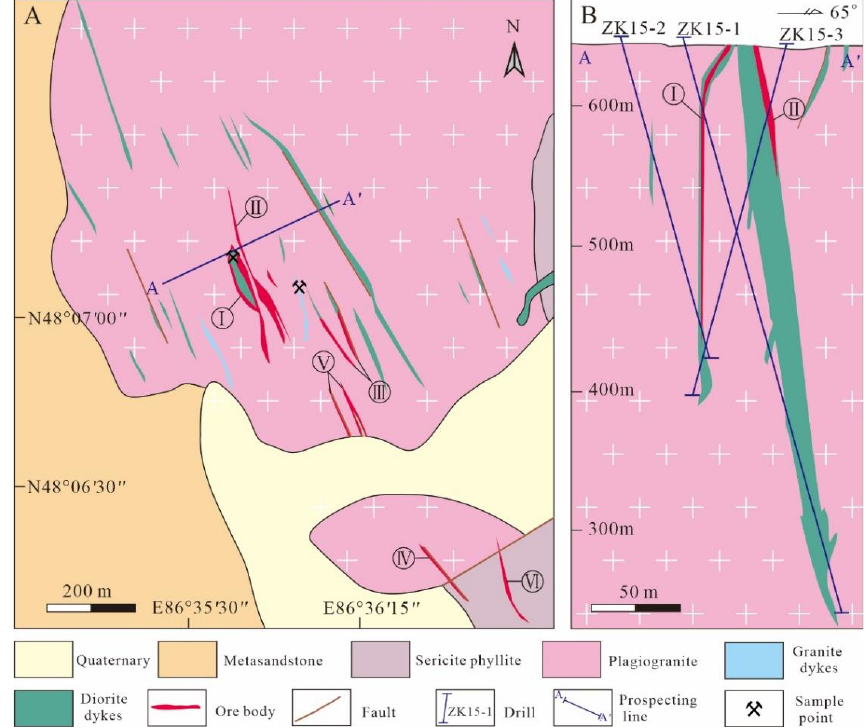
Figure 2. ( A ) Geological map of the Jinba gold deposit (I – VI indicates the number of ore body, mod- ified after Wang et al. [21]). ( B ) Geological cross – section of the orebodies (modified after Wang et al.